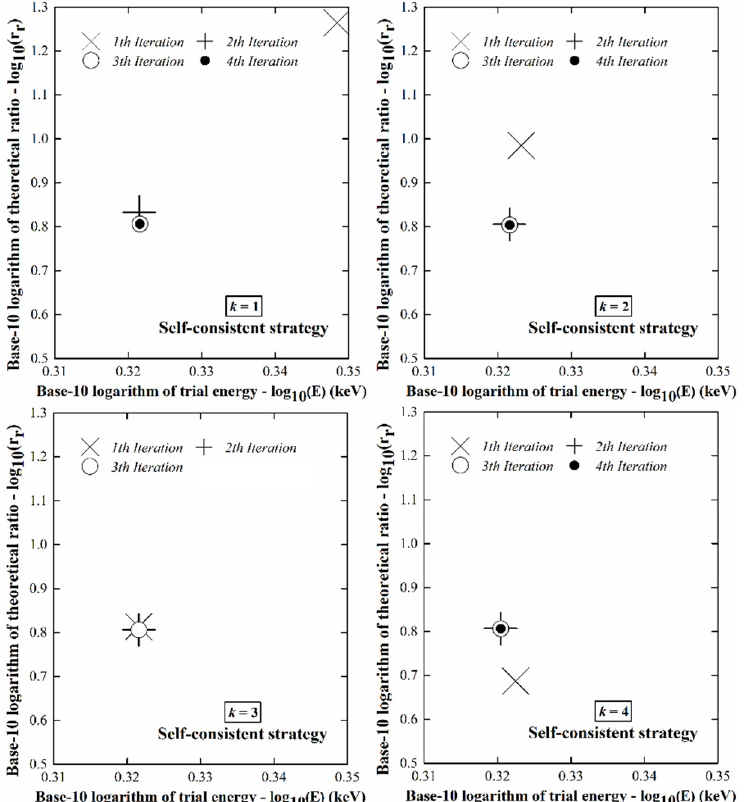
Figure 5. Base-10 logarithm of theoretical ratio r r varies with that of trial characteristic energy E for the self-consistent approximation.